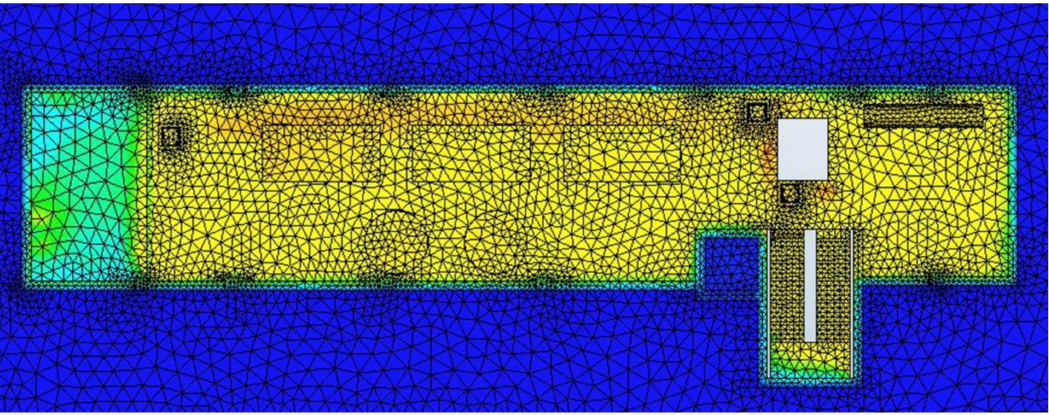
Figure 4. Automatic mesh